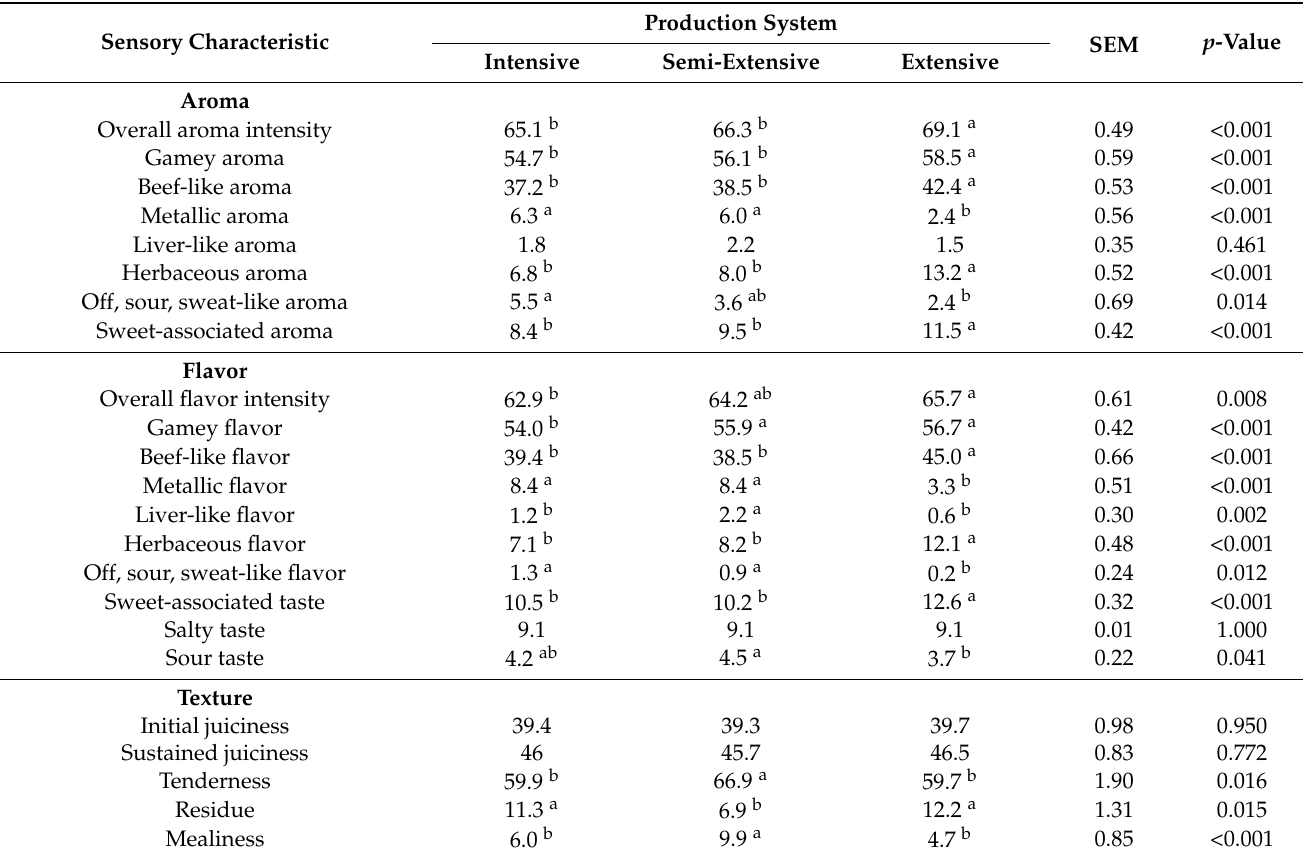
Table 6. LSMeans and the pooled standard error (SEM) of the sensory scores of sub-adult male impala longissimus thoracis et lumborum meat, as influenced by production system. A total mixed ration was fed in the intensive system ( n = 12), while supplementation (with the same ration) was provided on Savanna vegetation ( n = 12), and no supplementation was provided to the extensive system on Renosterveld vegetation ( n =